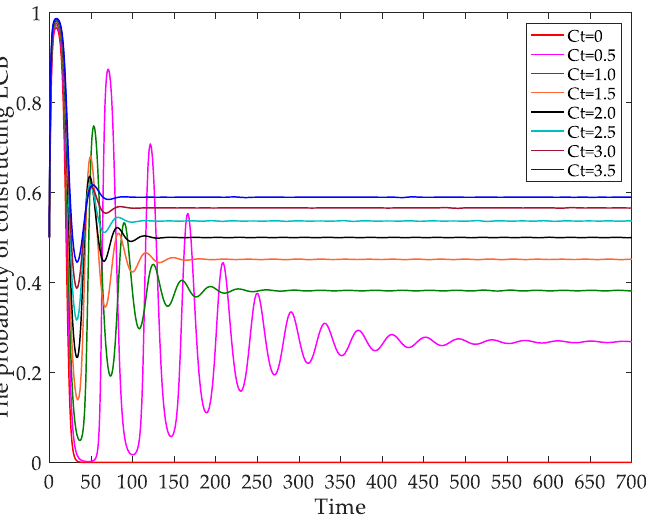
Figure 9. Evolutionary path of the behavior strategies of developers under different dynamic carbon tax rates. tax